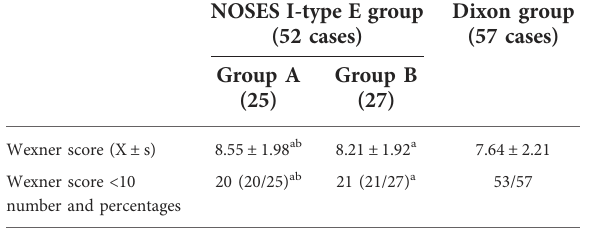
TABLE 5 Comparison of postoperative pathological indexes among the four groups.